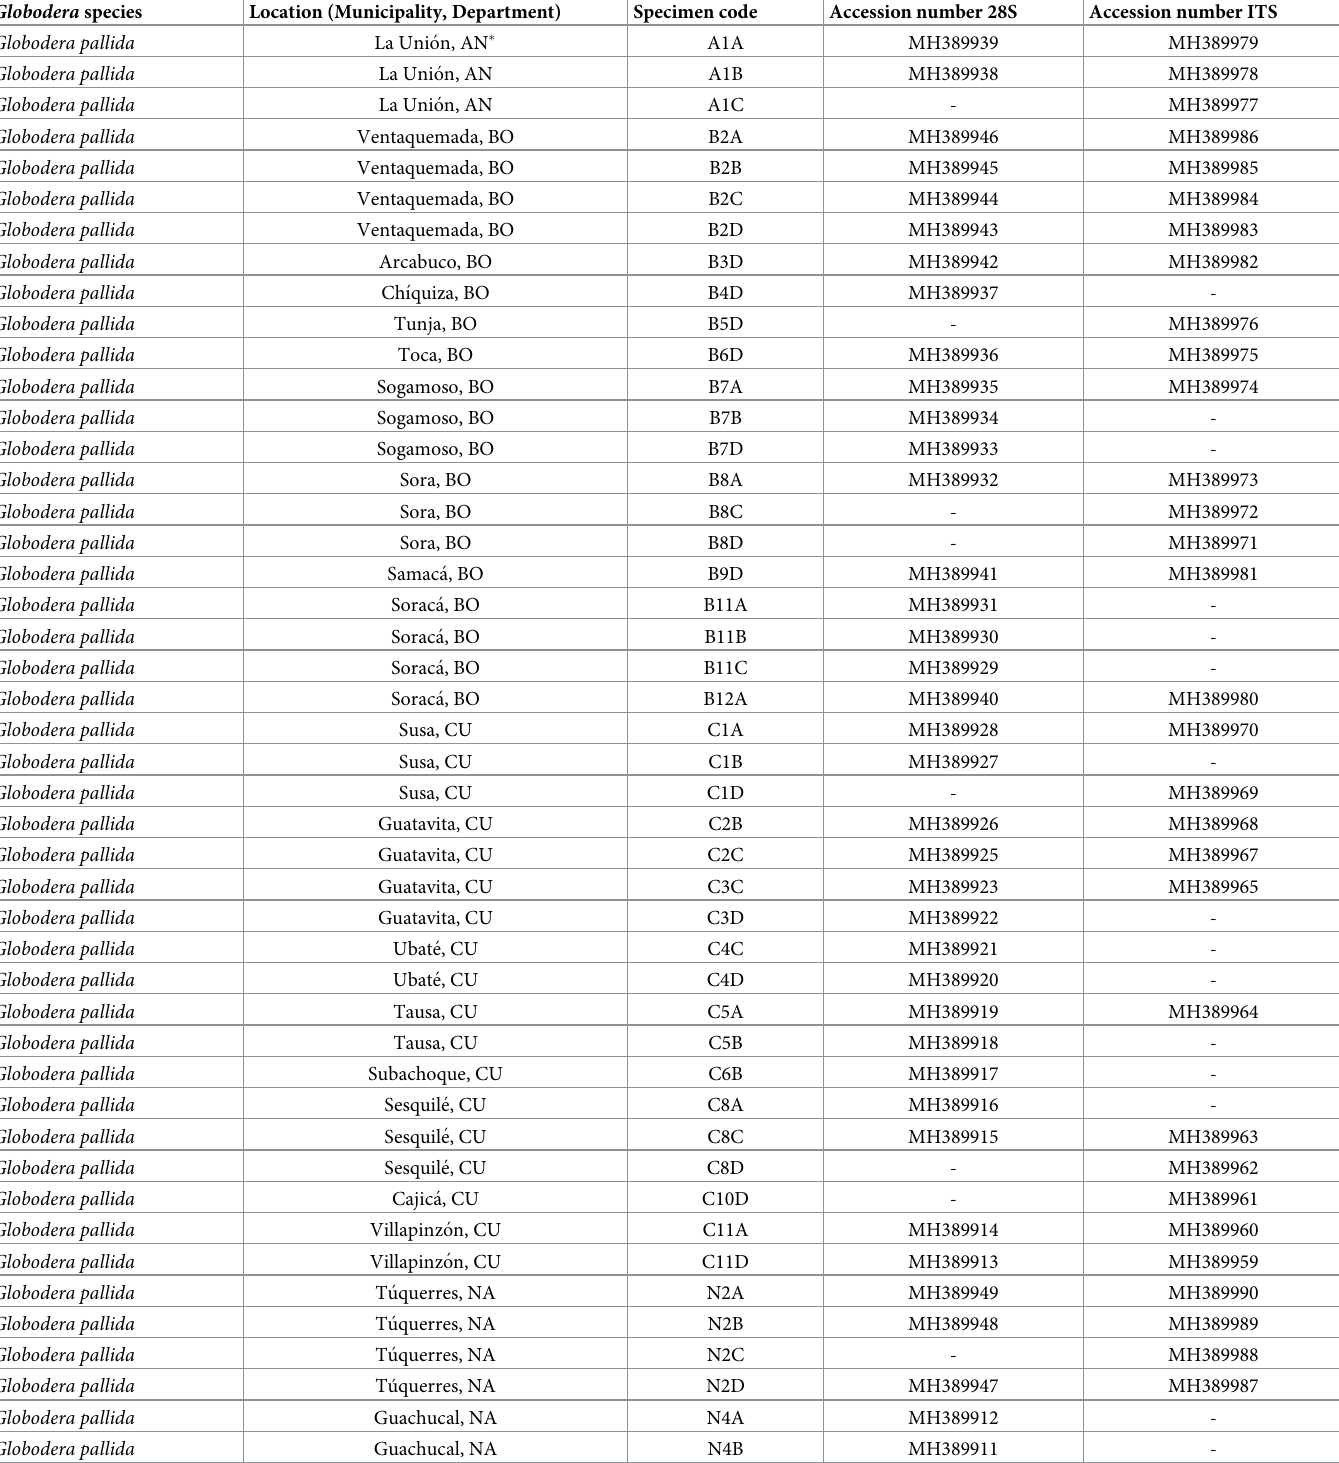
Table 3. Details of cyst nematode populations included in the molecular and phylogenetic studies from cultivated potatoes in Colombia and reported in other studies. Globodera